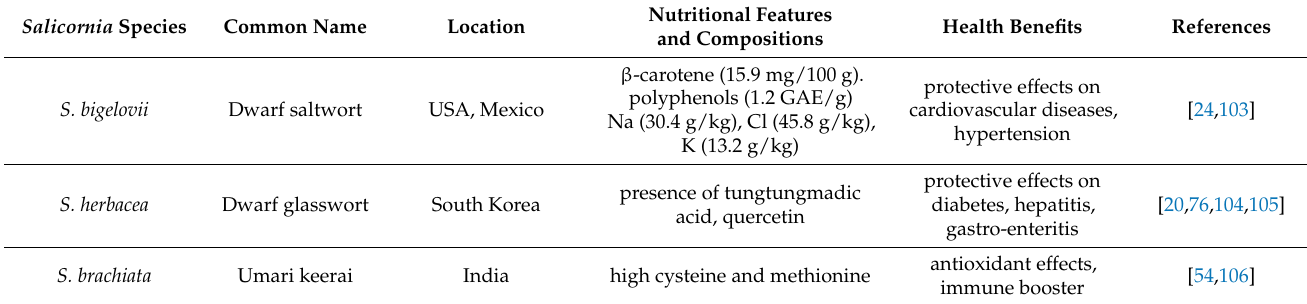
Table 1. The common geographical location of the three Salicornia species and their health benefits. Adapted from ref.